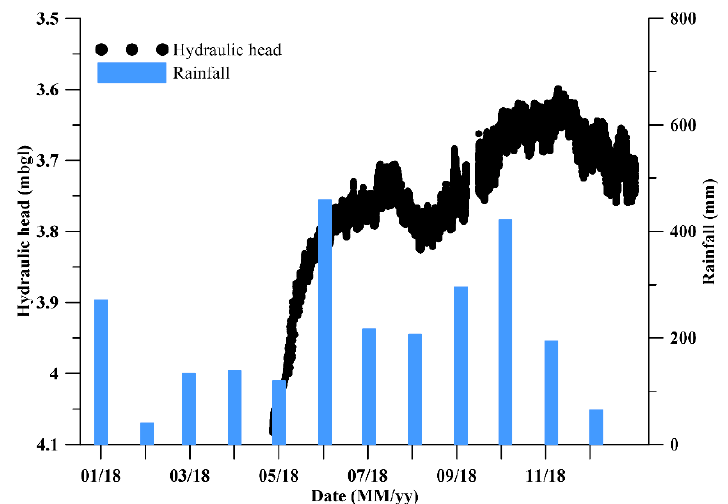
Figure 7. A chart showing water table fluctuation versus average monthly rainfall in 2018 from a station at CDPM.